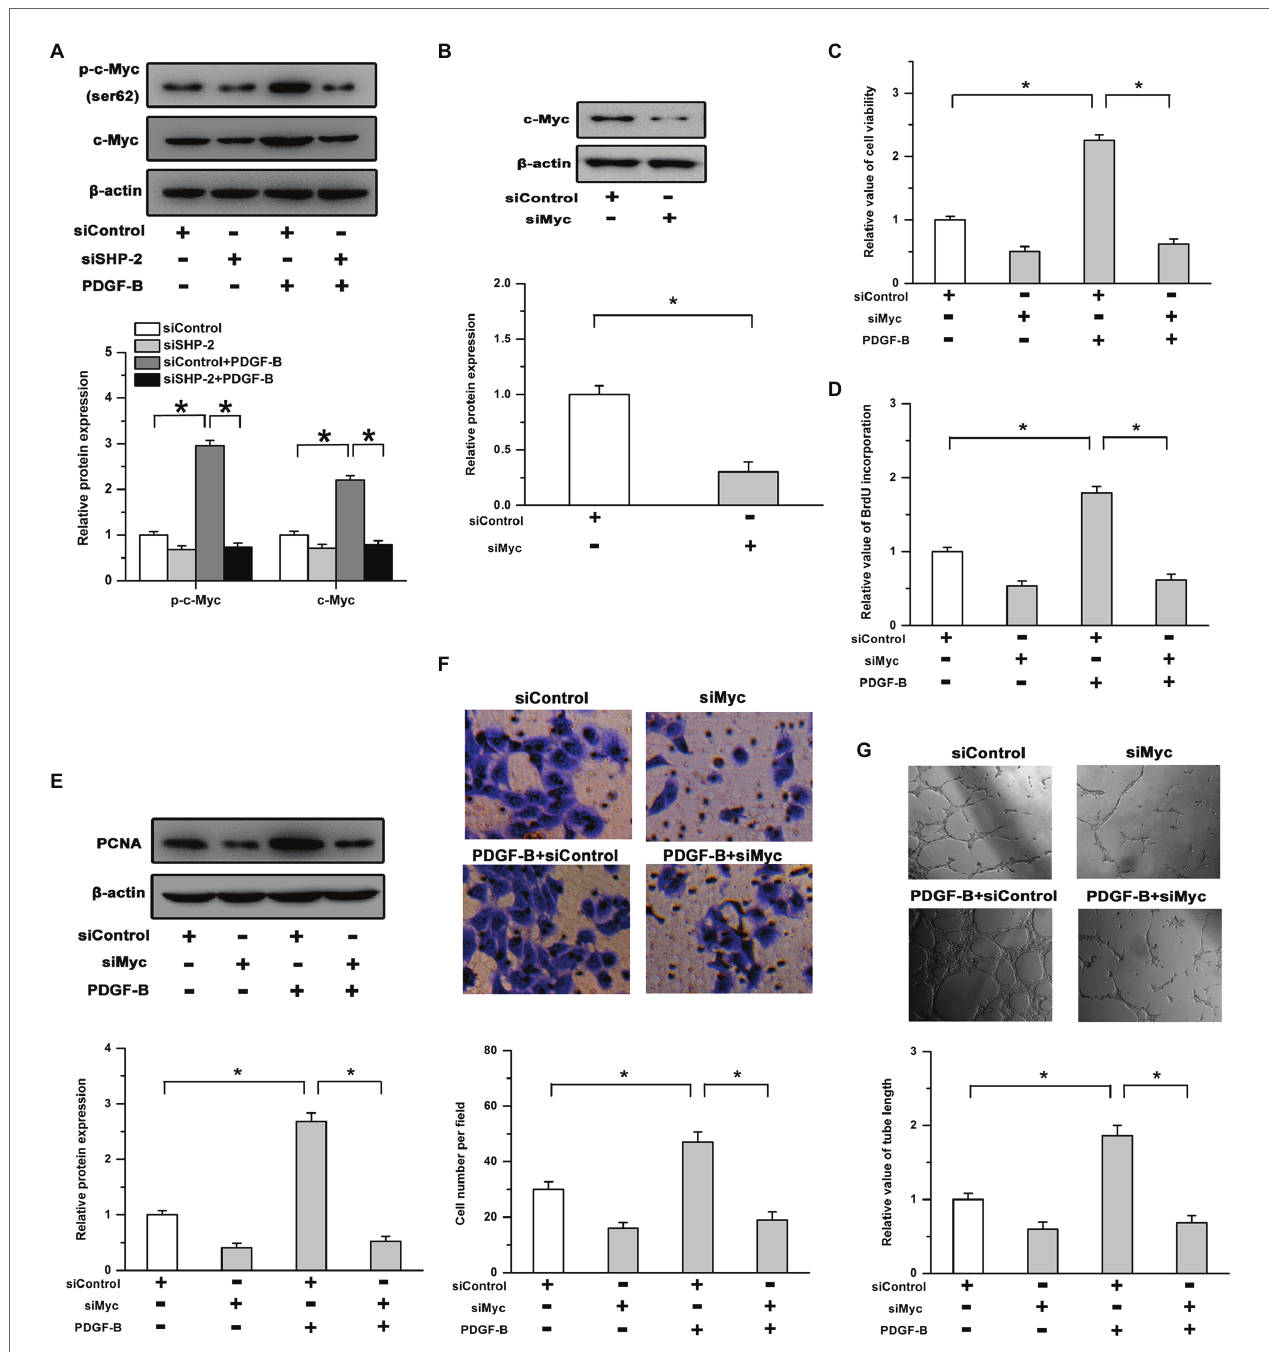
FIGURE 3 | The effects of PDGF-B/SHP-2 on cell growth and angiogenesis are mediated by c-Myc. (A) Treatment with PDGF-B induced the phosphorylation and expression of c-Myc, while knockdown of SHP-2 repressed the effects of PDGF-B. (B) The expression of c-Myc was significantly depressed by siMyc (an siRNA of c-Myc). (C,D) The cell viability (C) and BrdU incorporation (D) enhancements induced by PDGF-B treatment were attenuated by siMyc. (E) Knockdown of c-Myc weakened the promoting effects of PDGF-B on PCNA expression. (F,G) PDGF-B-facilitated cell migration (F) and tube formation (G) were abolished by knockdown of c-Myc. *indicates p <